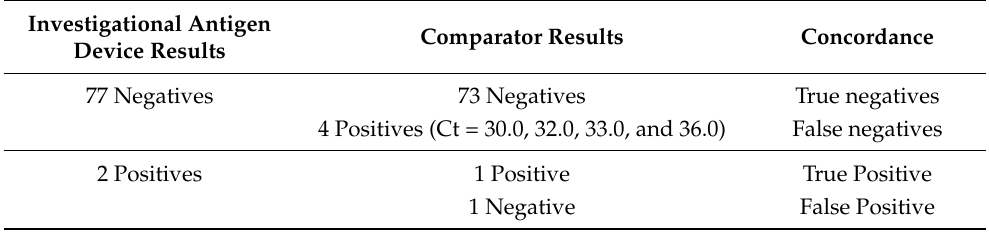
Table 3. Analysis of the 79 subjects with prior known COVID-19 negative results.